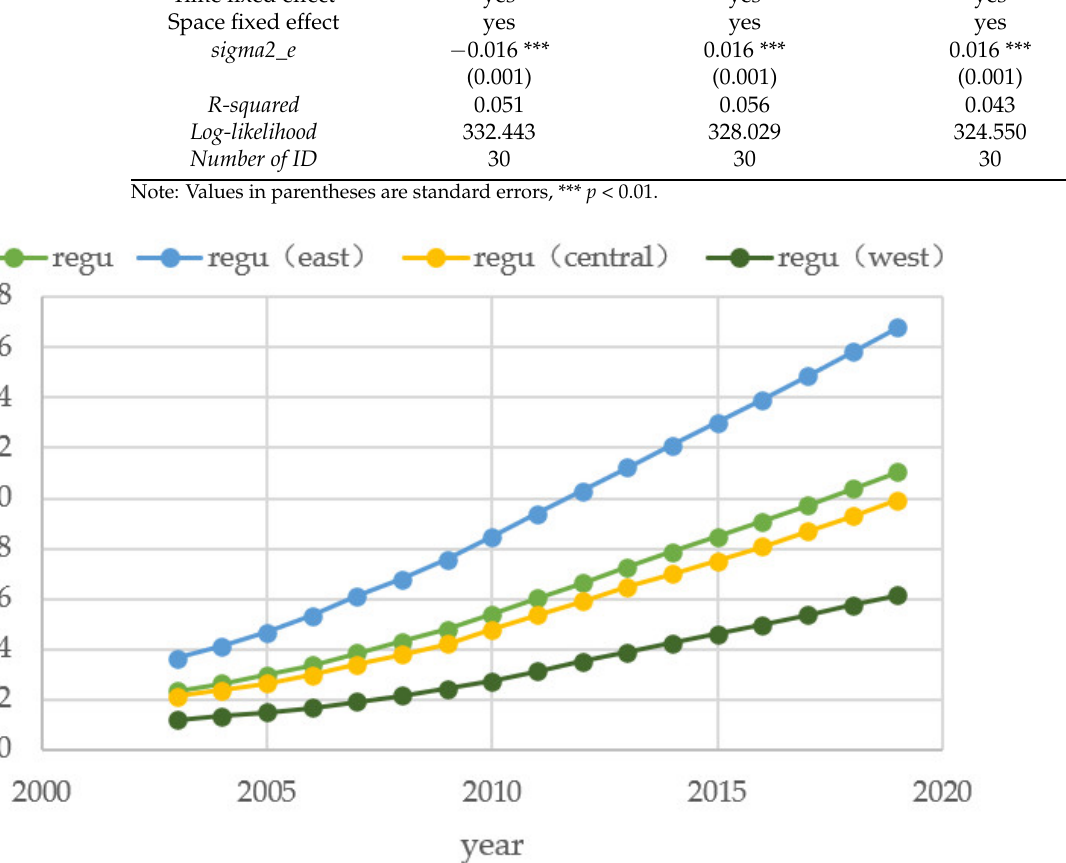
Table 13. Regression results of the impact of environmental regulation competition on carbon emis- sions by region. (1)